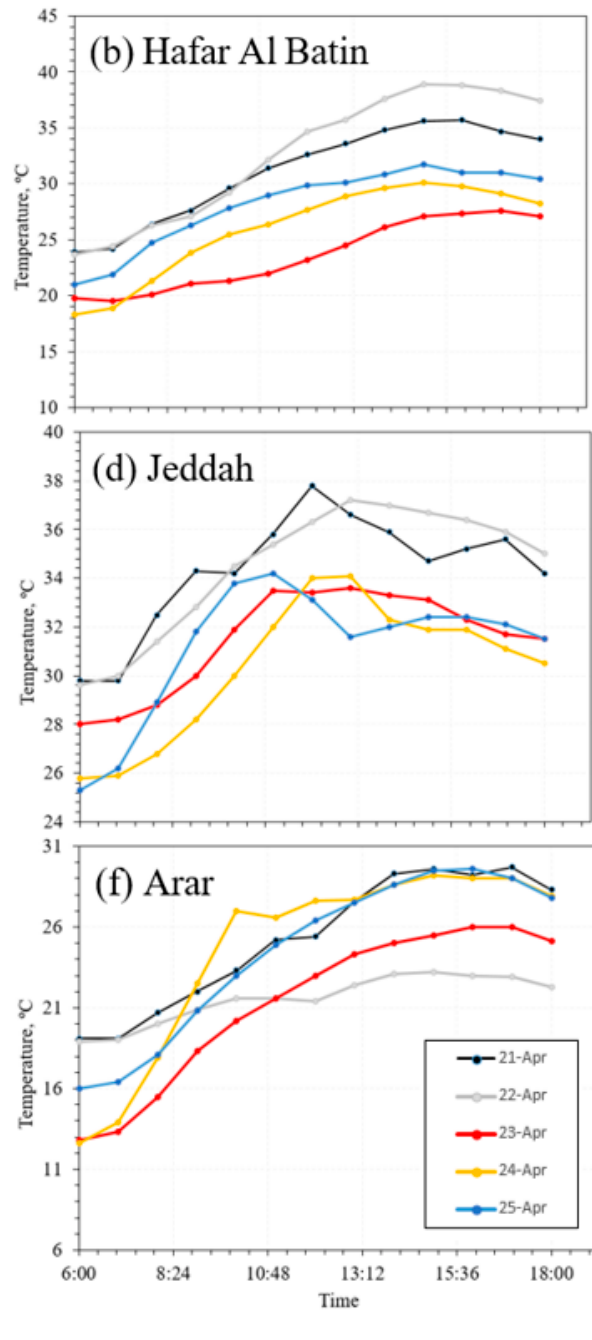
Figure 7. Air temperature variability ( ◦ C) over six Saudi cities ( a ) Dammam, ( b ) Hafar Al Batin, ( c ) Riyadh, ( d ) Jeddah, ( e ) Najran, and ( f ) Arar from 21 to 25 April 2018.